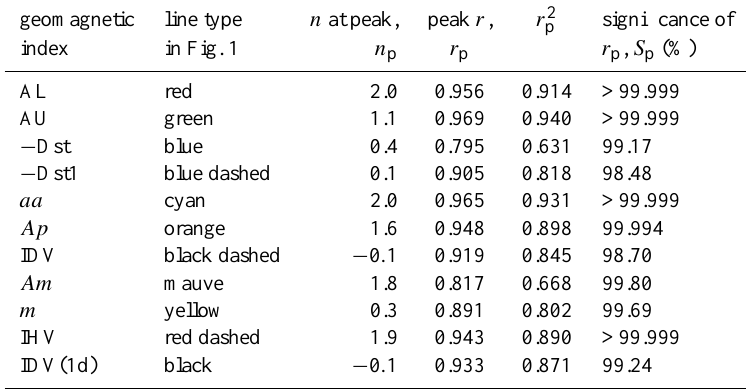
Table 1. Details of the correlation at the peaks of each correlogram in Fig. 1. geomagnetic line type n at peak, peak r , r 2 p significance